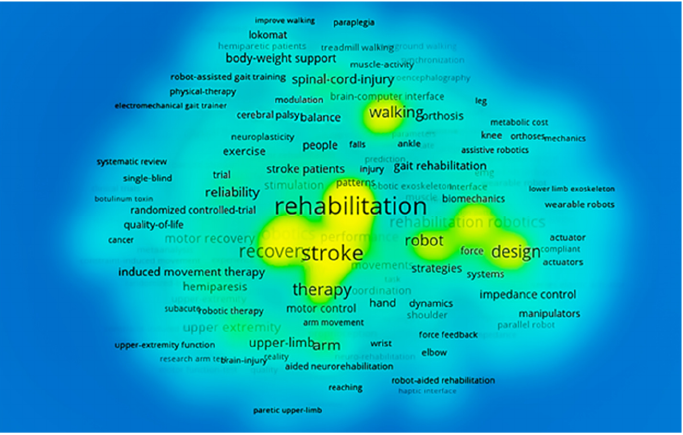
Figure 6. Density visualization of keyword co-occurrence with frequency >